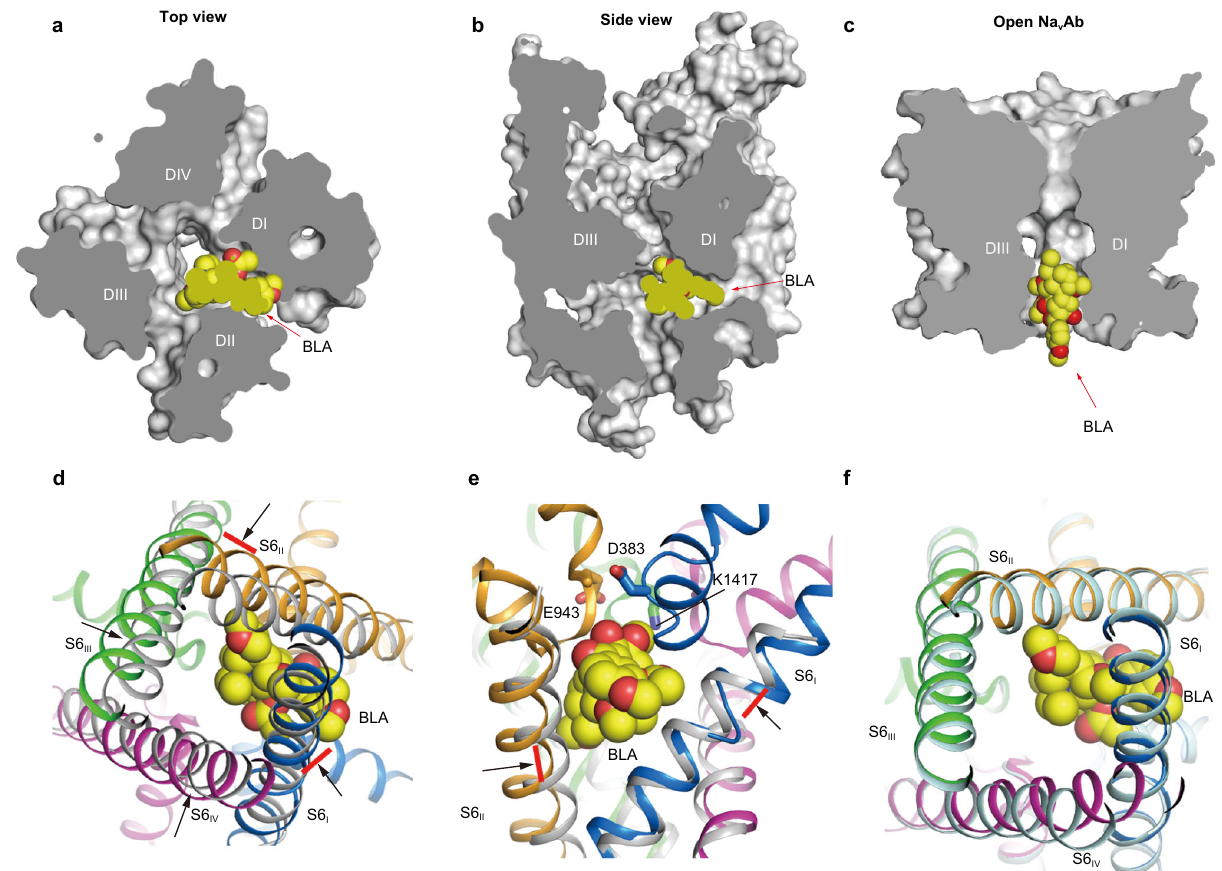
Fig. 3 Structure basis for modulation of Na V 1.3 by BLA. a , b Cut-open sliced views of the Na V 1.3 pore module shown in surface from top-down and side, respectively. c Space- fi lling of the open activation gate of Na V Ab (PDB code: 5VB8) with BLA shown in spheres. d , e Binding of BLA physically blocks the contraction of Na V 1.3 activation gate compared to the closed gate of resting state Na V Ab (PDB code: 6P6W, colored in gray). Black arrows indicate shift of each S6 when transition to the closed resting state, and red bars indicate where the shifts are blocked. BLA is shown in a sphere model, and key residues for the selectivity fi lter are shown in sticks. f Structural comparison of the activation gate of Na V 1.3 with the open state of Na V Ab (PDB code: 5VB8, colored in light